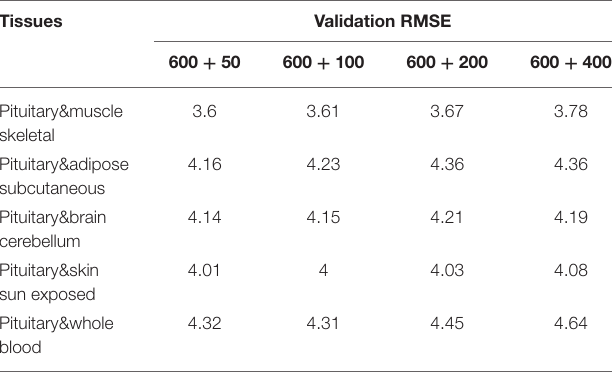
TABLE 3 | Prediction accuracy by combining double